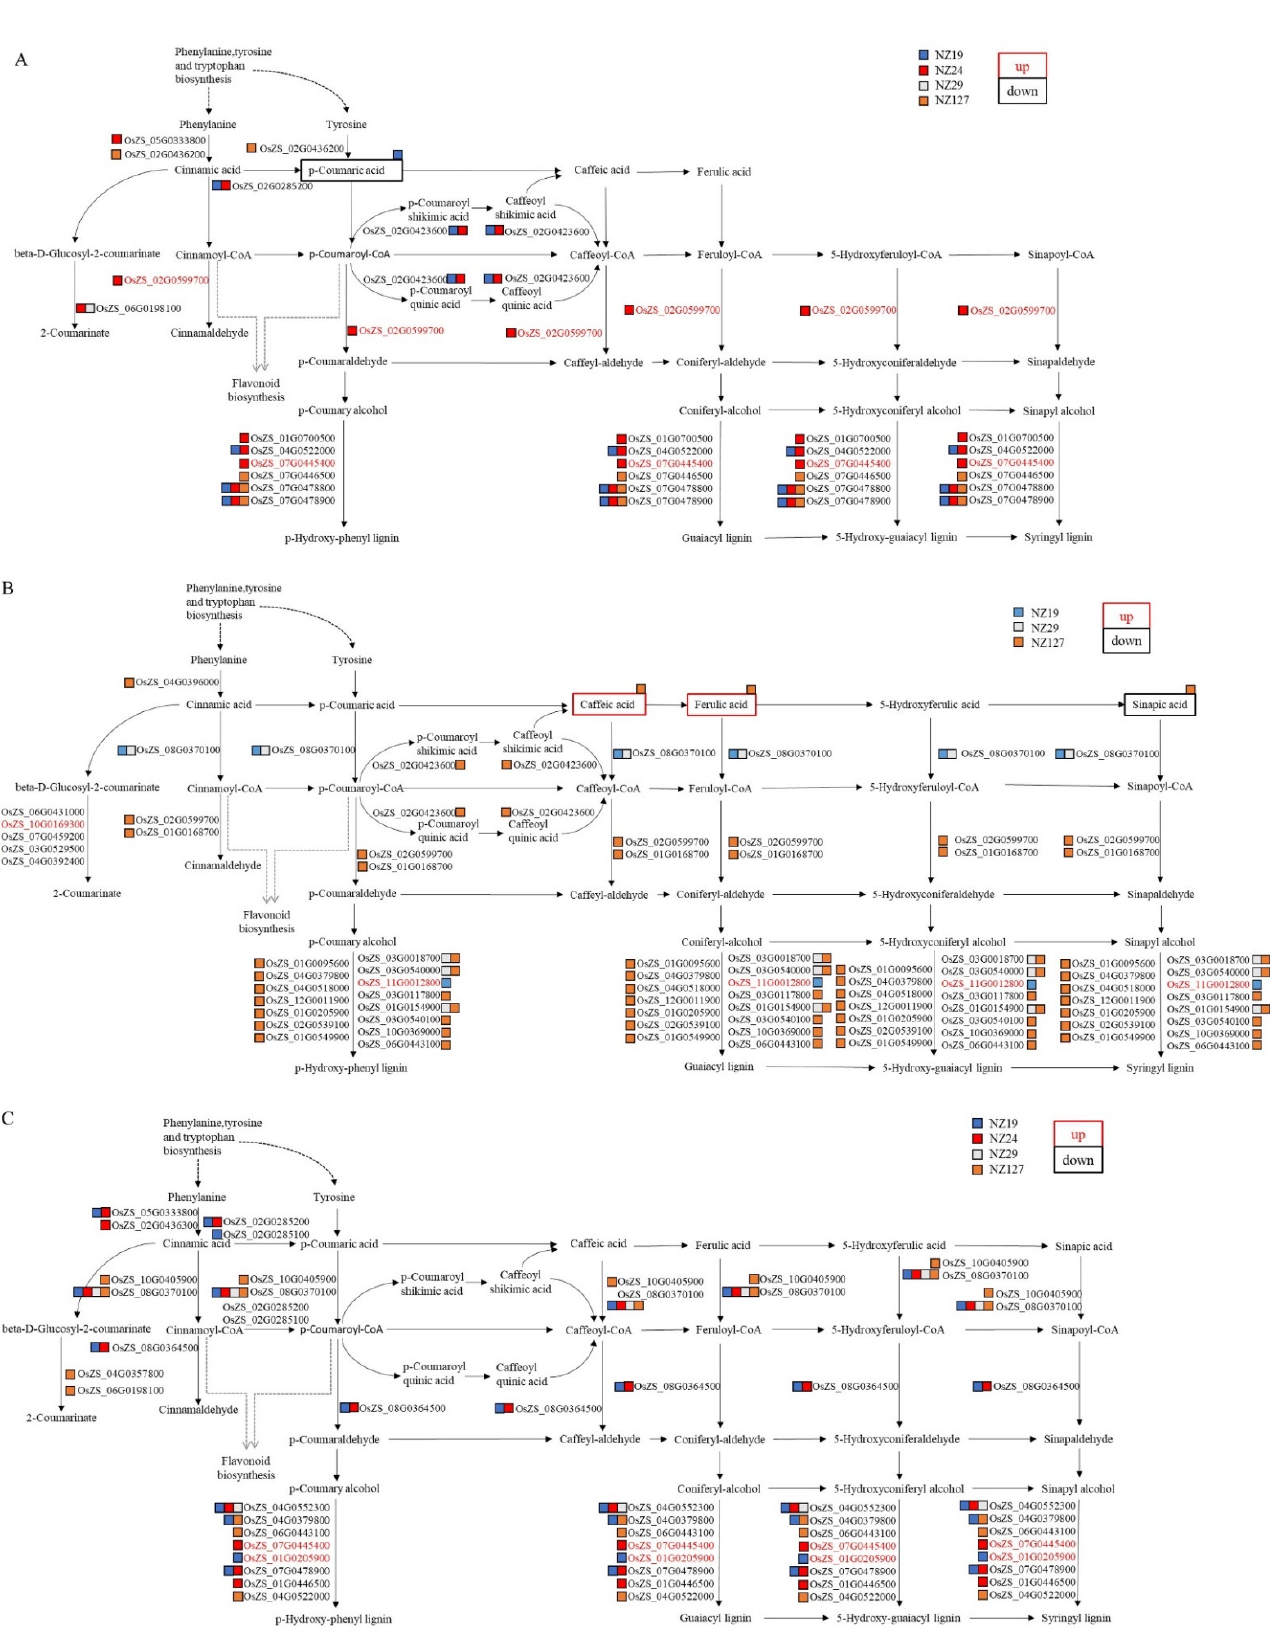
Figure 11. Differential expressed genes and differential accumulated metabolites mapped on phenylpropanoid biosynthesis pathway of embryo ( A ), endosperm ( B ), and aleurone layer ( C ).